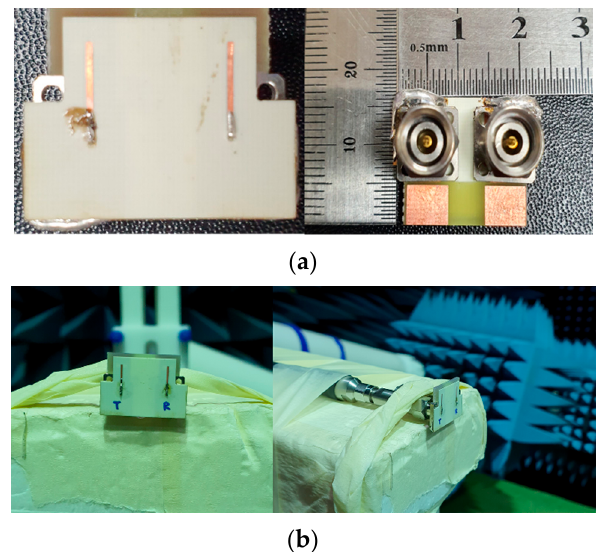
Figure 4. Fabrication and measurement setup of slot-type Doppler radar antenna: ( a ) fabrication; ( b ) measurement setup.